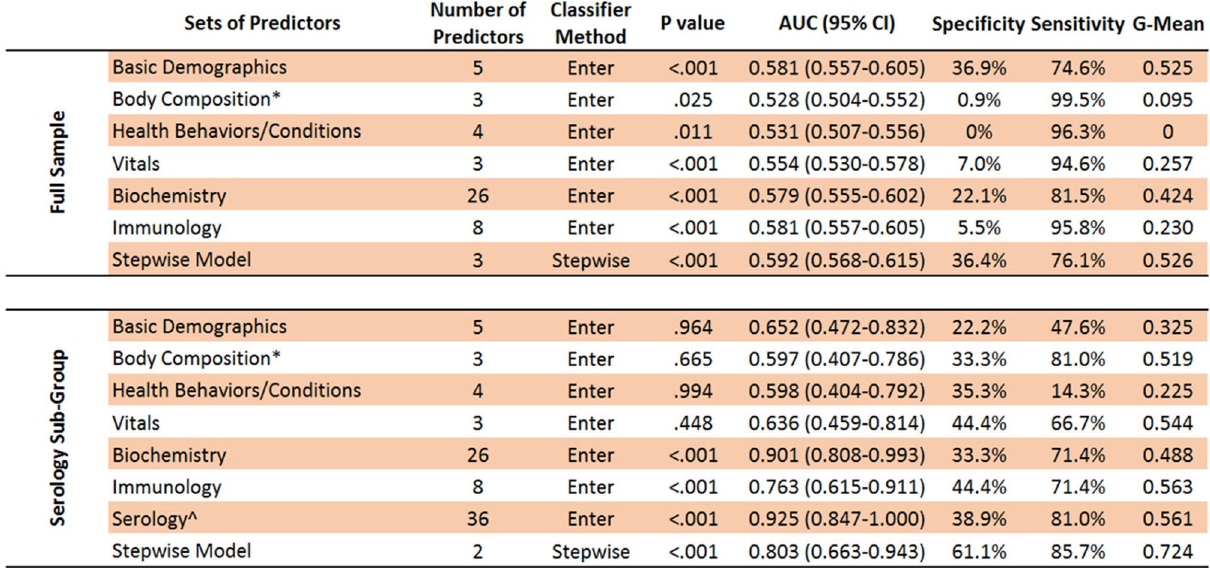
Table 4. Sets of predictors used to predict classification of COVID-19 positive cases as mild or severe. Area Under the Curve (AUC); Confidence Interval (CI); Geometric Mean (G-Mean). Non-parametric bootstrapping (1000 iterations, 95% CI) was used for robust estimation. P values less than 0.05 were considered significant. “bold” and “italics” shading are used to distinguish between predictors that loaded for a given model. a Due to several variables representing the same construct (i.e., being multicollinear), body composition consisted of: whole-body water mass; whole-body fat mass; whole-body non-fat mass (i.e., muscle, bone). b Due to the full serology panel of 44 antibody titers exceeding degrees of freedom, titers for 6 antigens were excluded for pathogens with the lowest estimated prevalence in the cohort (HIV, HCV,